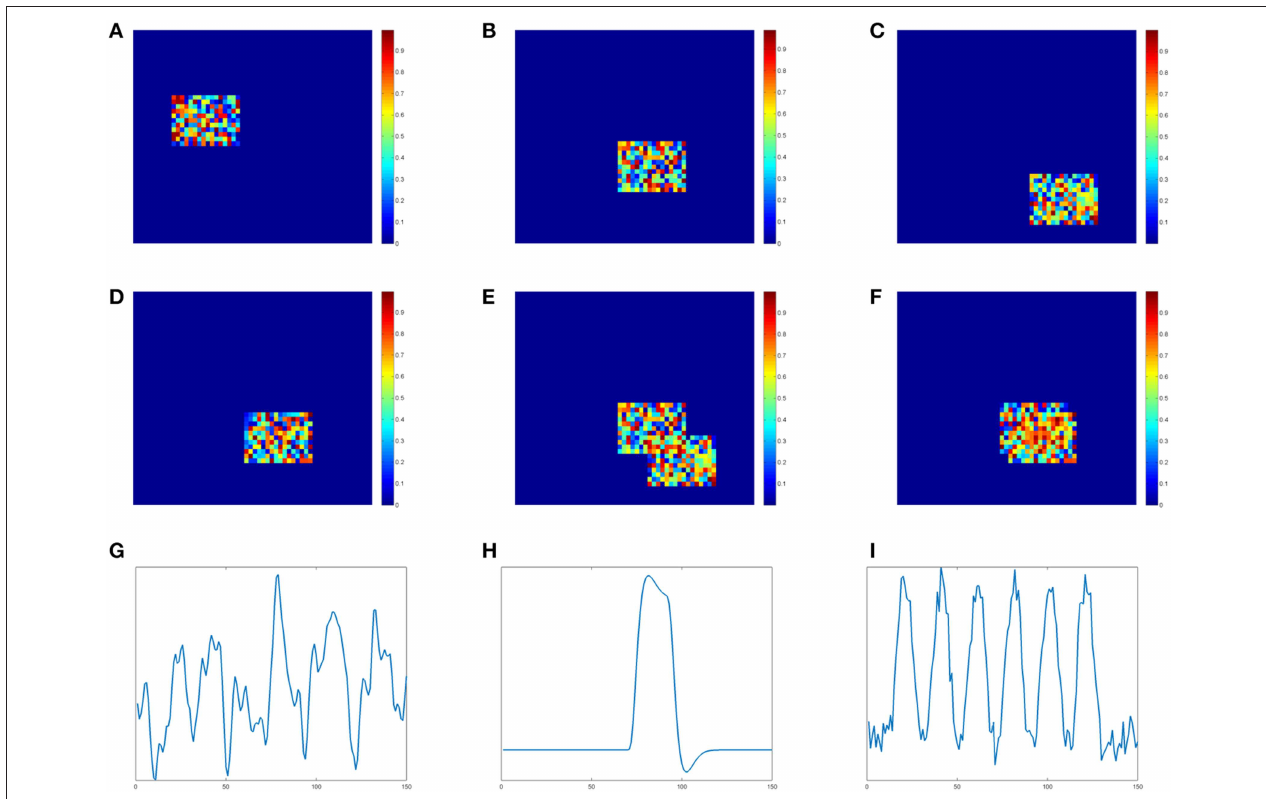
FIGURE 1 | Simulation data of spatial components(SC) and time courses(TC). (A) SC 1. (B) SC 2. (C) SC 3-low overlapping. (D) SC3 high overlapping. (E) SC2&3 low overlapping. (F) SC2&3 high overlapping. (G) TC1. (H) TC2. (I) TC3.